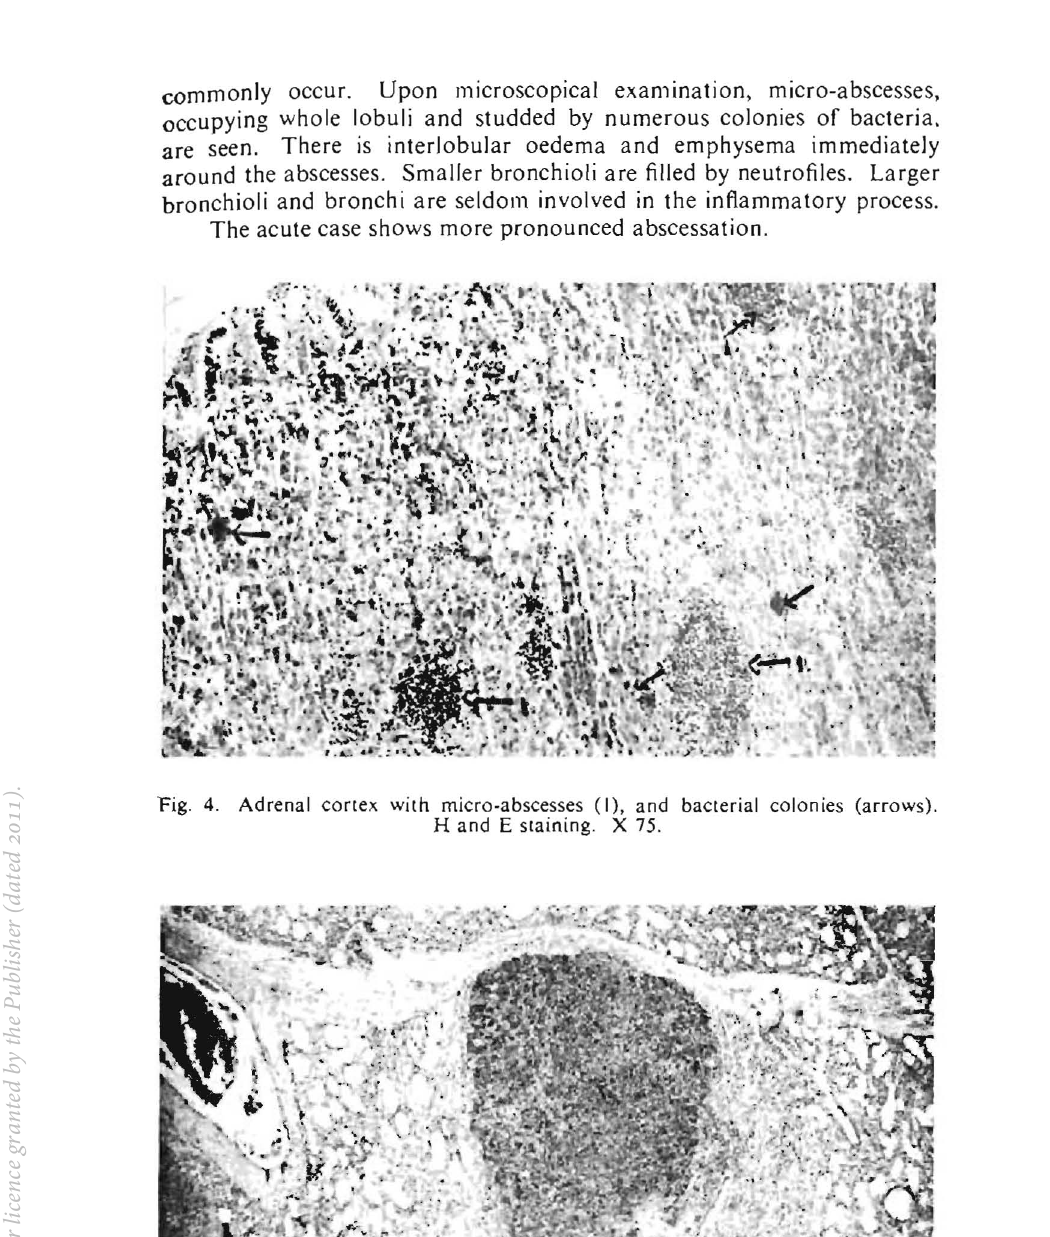
Fig. 5. Lung. Micro-abscess, studded by bacterial colonies, surrounded by hyper aemic zone and emphysema; interlobular oedema. Hand E staining. X30.